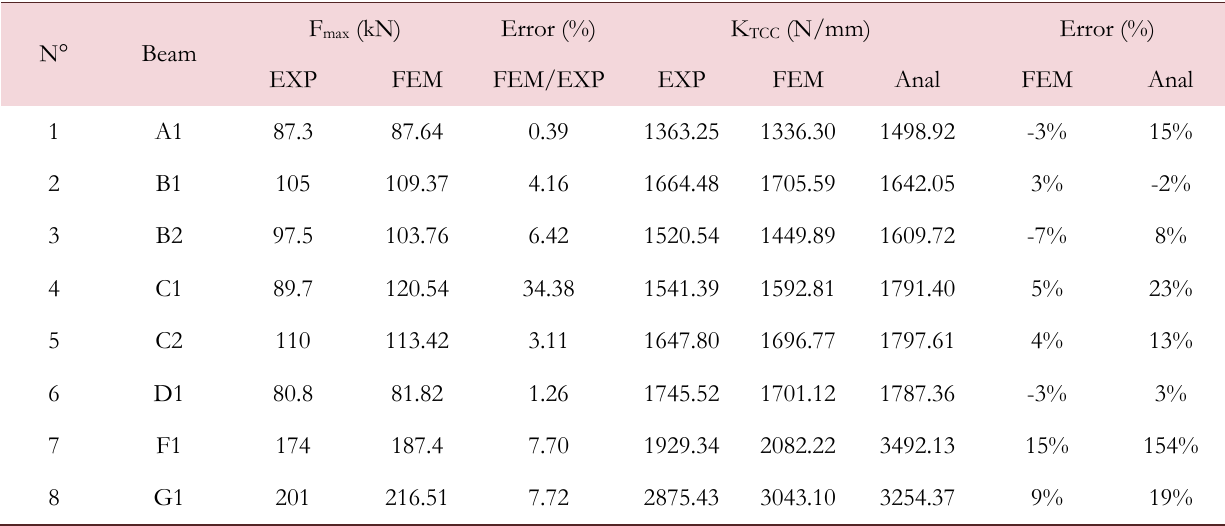
Table 5: Validation of the main results: strength and stiffness obtained by numerical analysis and the experimental [17]. The first observation is that the FEM curves are on the safe side compared to the experimental